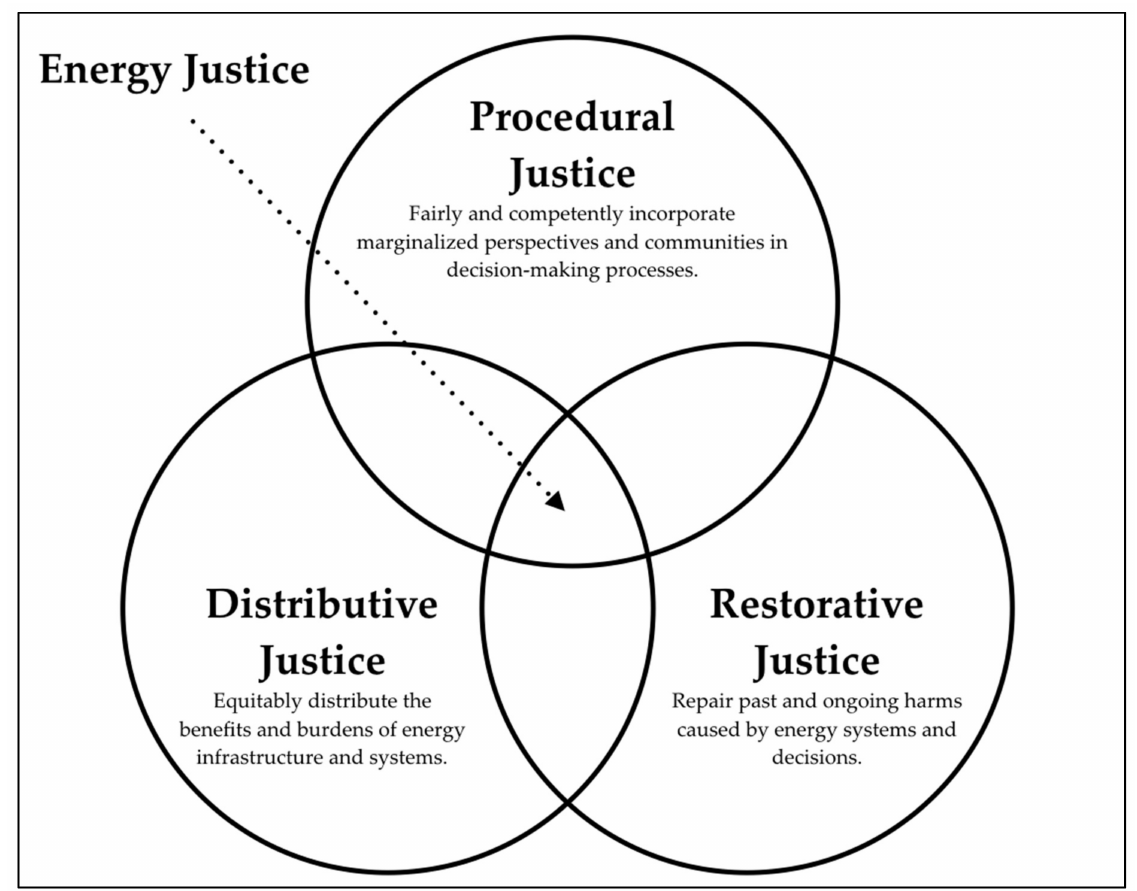
Figure 1. Three core energy justice